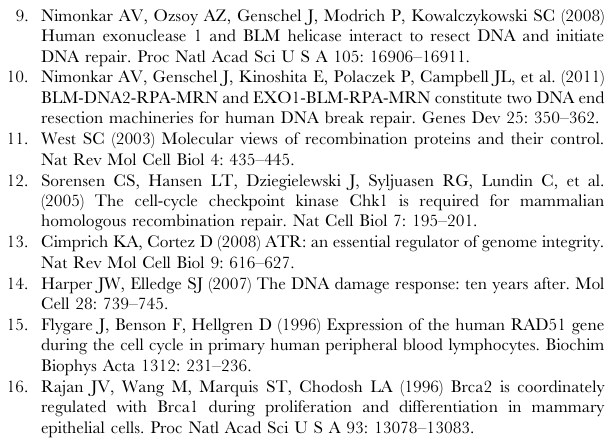
Figure S3 Impairment of RPA foci formation and checkpoint activation in CBP and p300 depleted cells.